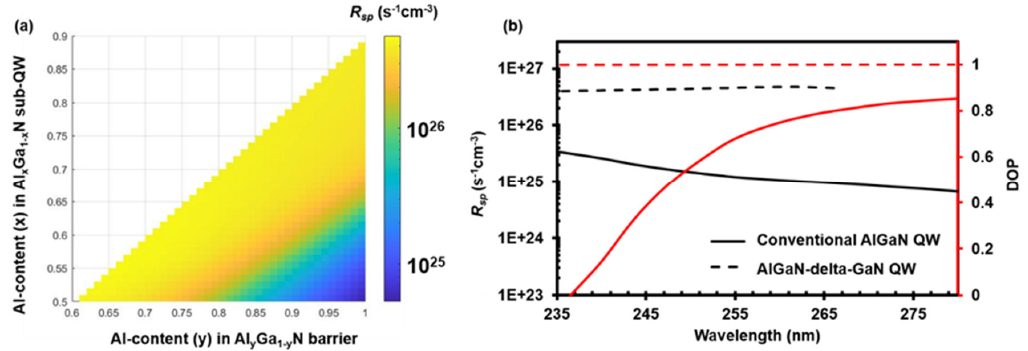
Figure 4. ( a ) Spontaneous emission rate color map for a 3 Å AlGaN-delta-GaN QW with di ff erent sub-QW and barrier compositions. Band structure and wave function of Al 0.5 Ga 0.5 N-delta-GaN QW with ( b ) R sp values from conventional AlGaN QW (solid line) and the highest R sp value from AlGaN-delta-GaN QW (dash line) at di ff erent wavelengths; red line plots the degree of polarization (DOP) from the conventional AlGaN QW.